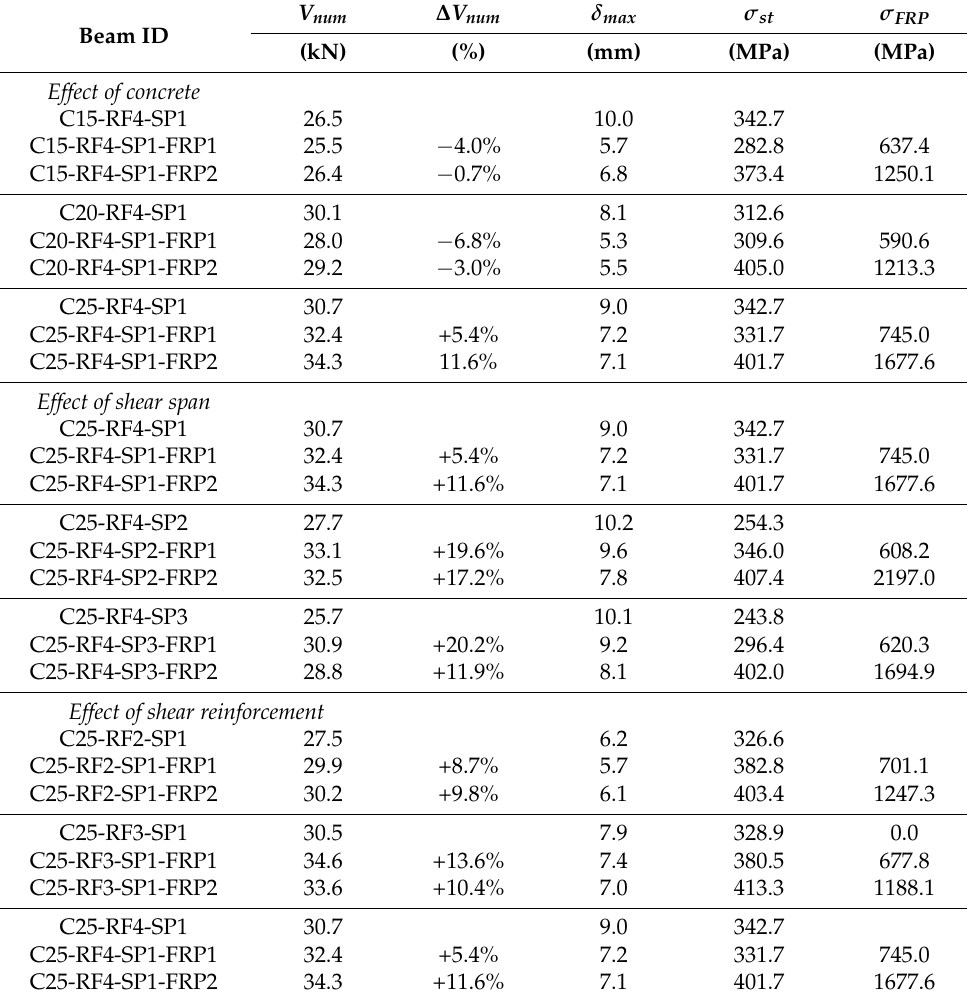
Table 8. Summary of the parametric finite-element modelling